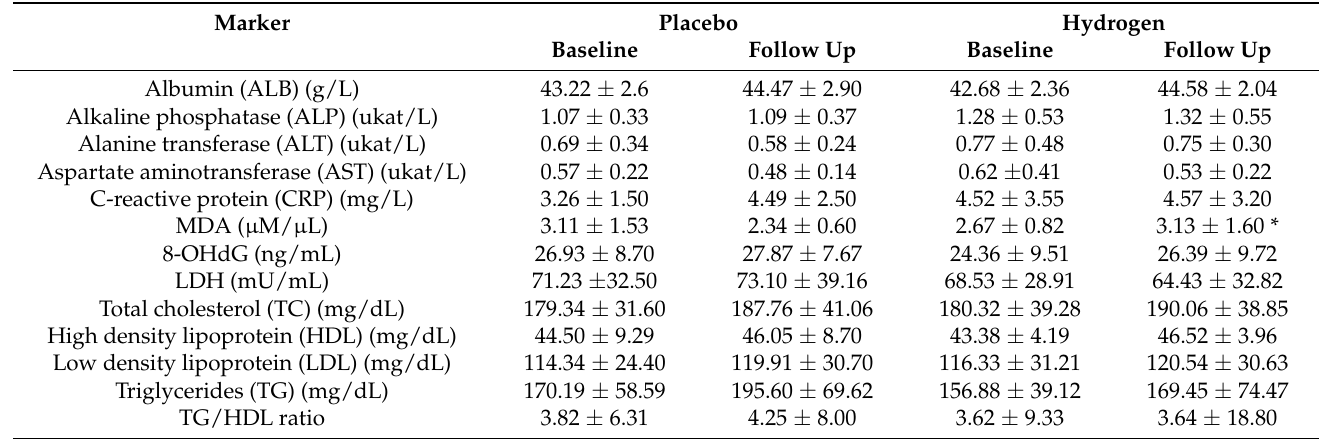
Table 3. Plasma biochemical markers from baseline and after 8-week